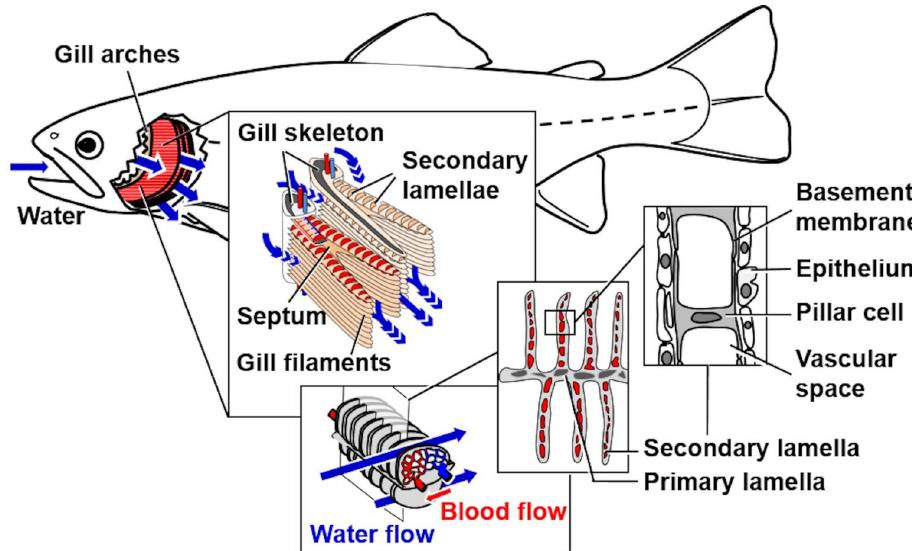
Fig 2. Schematic illustration of the 3-D histo-architecture of the gills and corresponding 2-D histological sections.